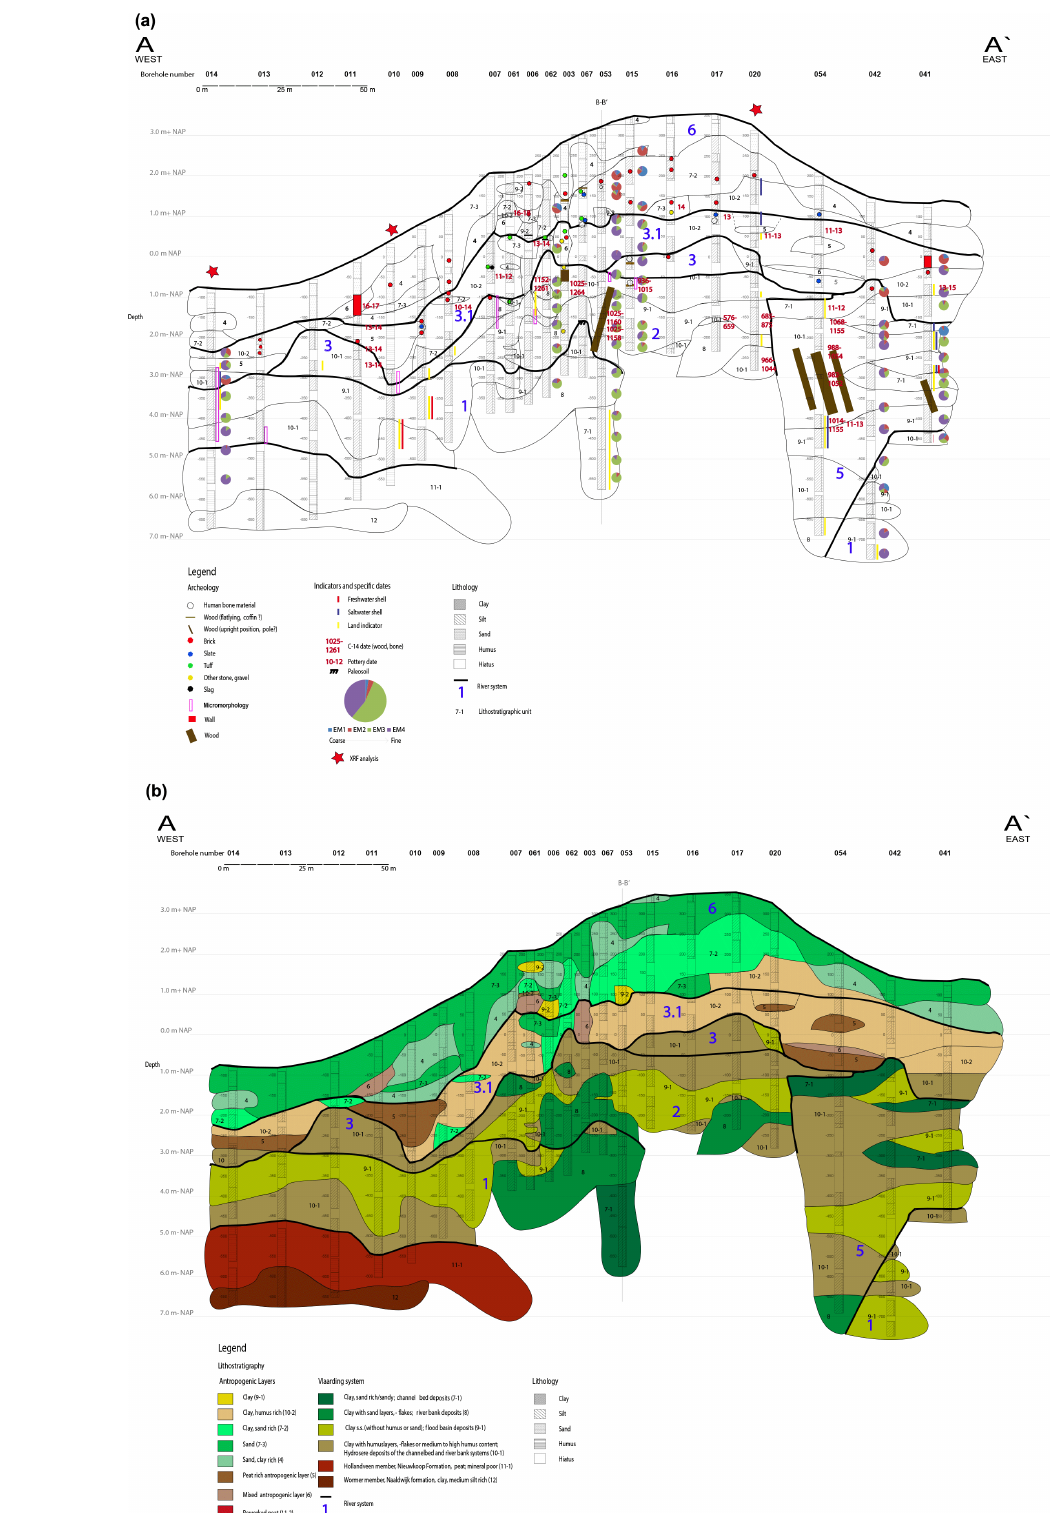
Figure 5. (a) East–west (A–A (cid:48) ) cross-section of mound of Vlaardingen Stadshart and its natural subsurface with data sheet. (b) East–west (A–A (cid:48) ) cross-section of mound of Vlaardingen Stadshart and its natural subsurface.